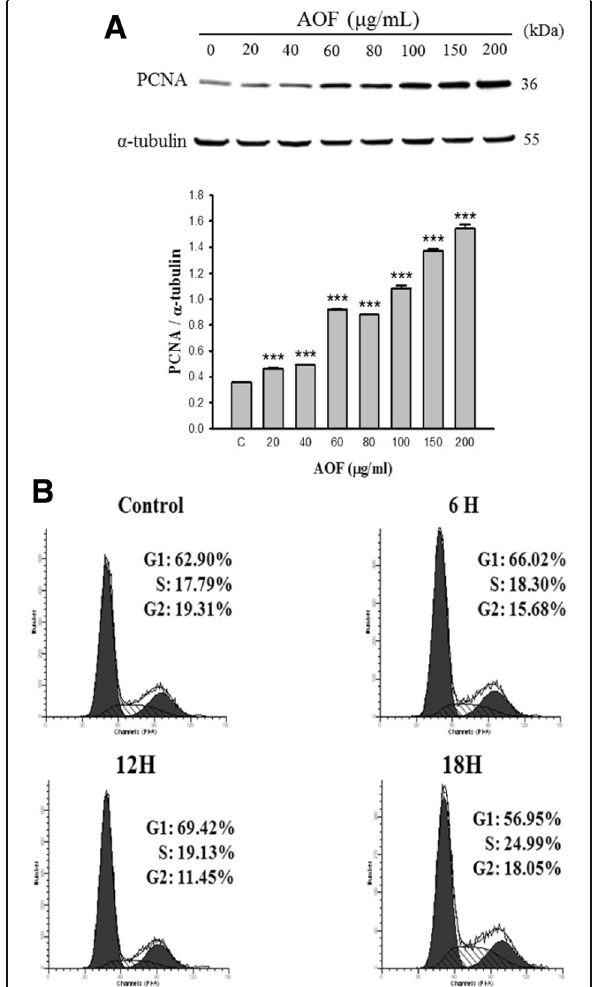
Fig. 3 AOF extract induce the expression of PCNA and promote G 1 progression. RSC96 cells were stimulated for 24 h. a As shown by western blot analyses, AOF treatment upregulated PCNA in a dose- dependent manner. α -tubulin was used as a loading control. b Cell cycle distribution was analyzed using flow cytometry. The proportion of RSC96 Schwann cells were increased significantly in the S phase, but decreased dramatically in the G1 phase at 12 h – 18